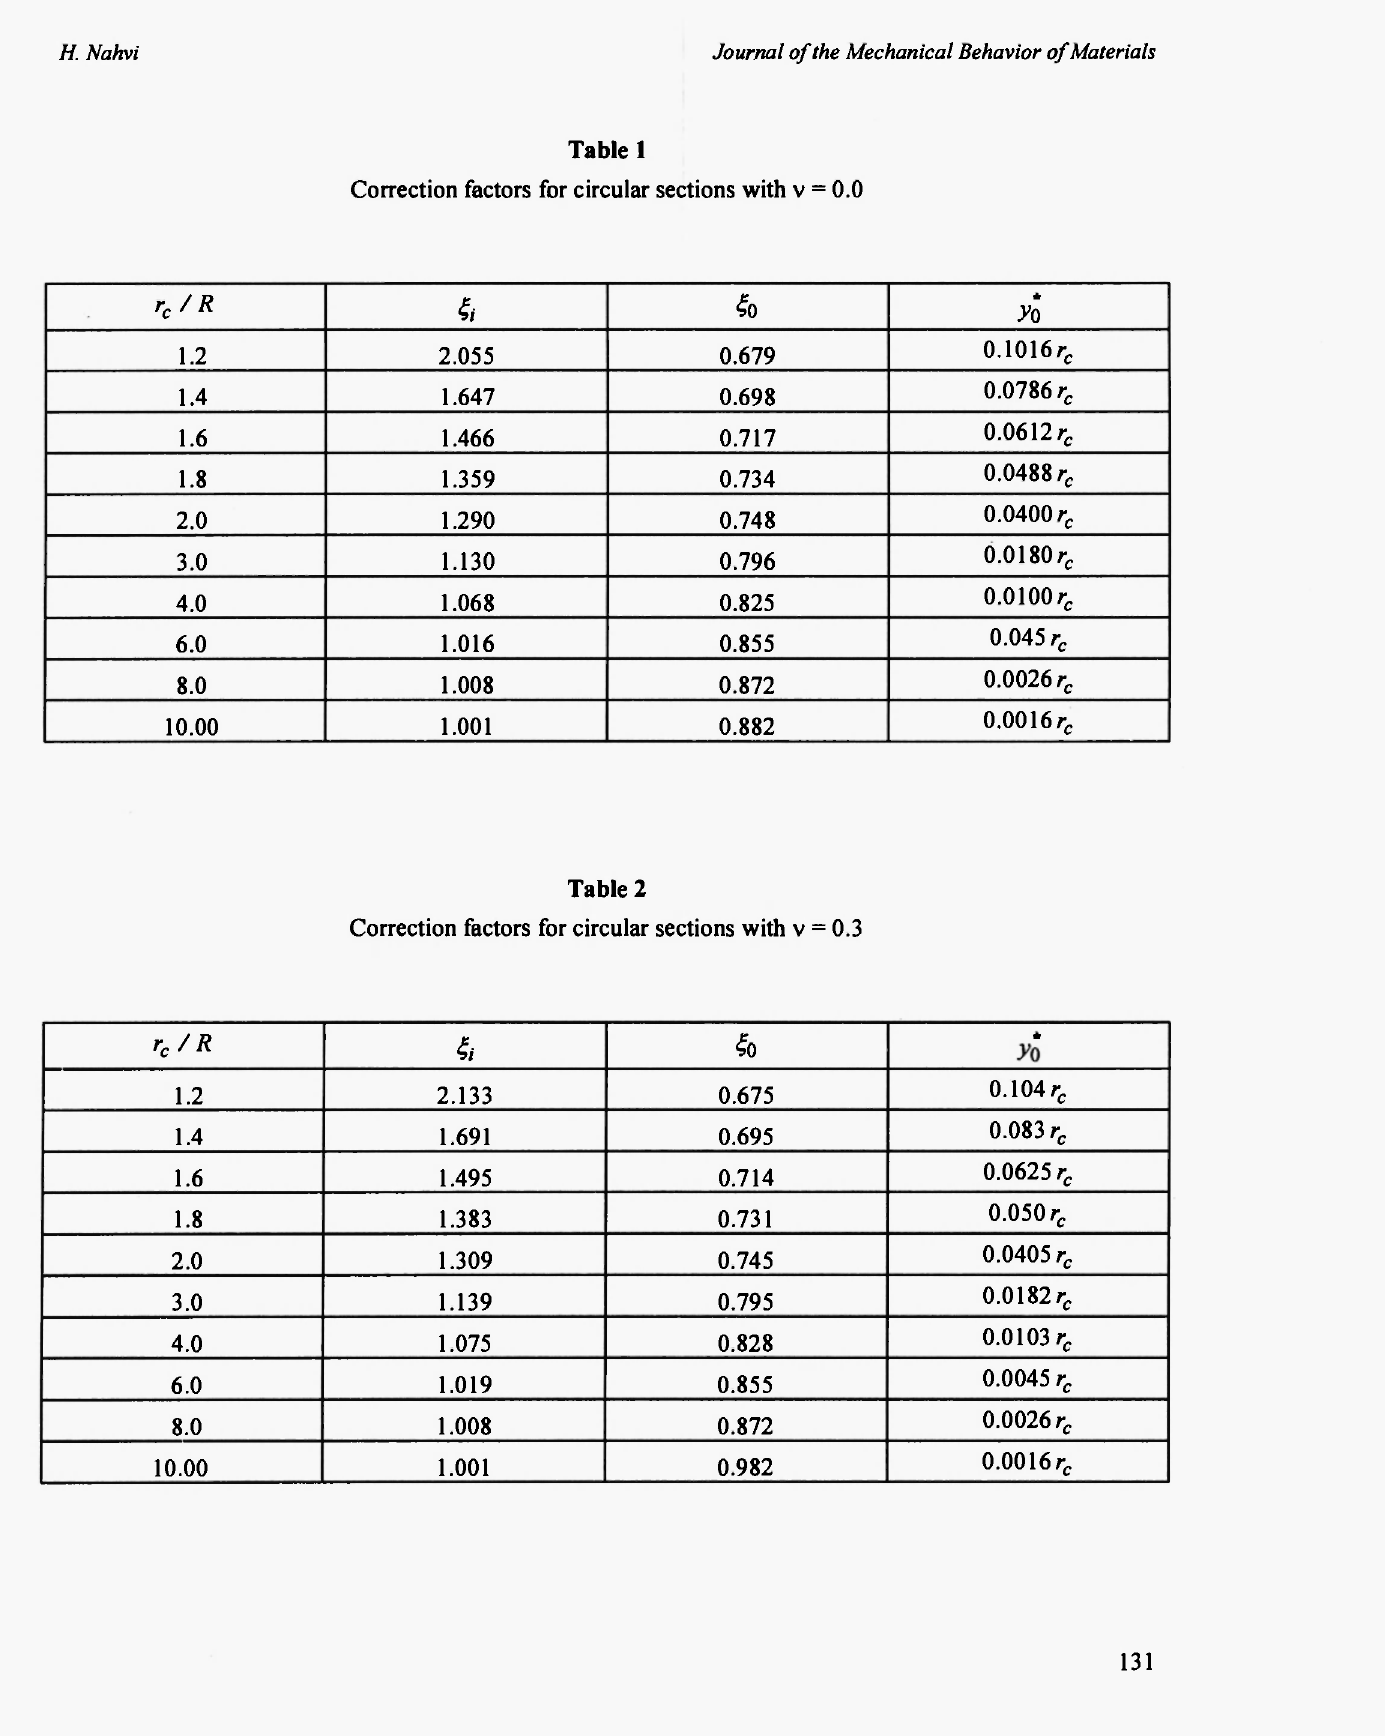
Correction factors for circular sections with ν =